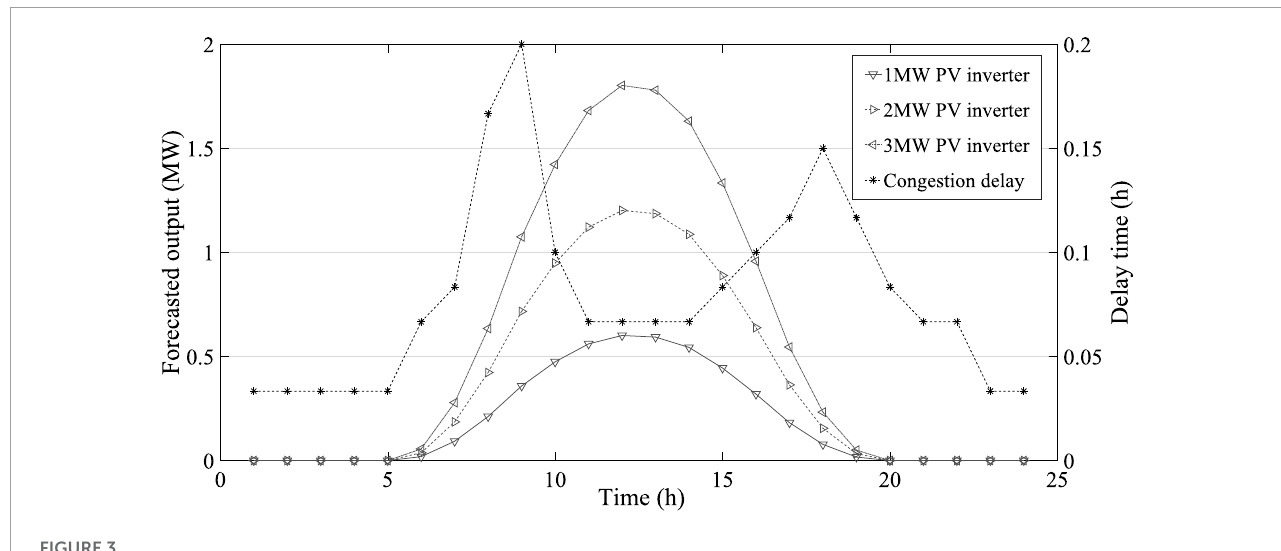
FIGURE 3 Hourly output of PV inverter and traffic congestion delay time of